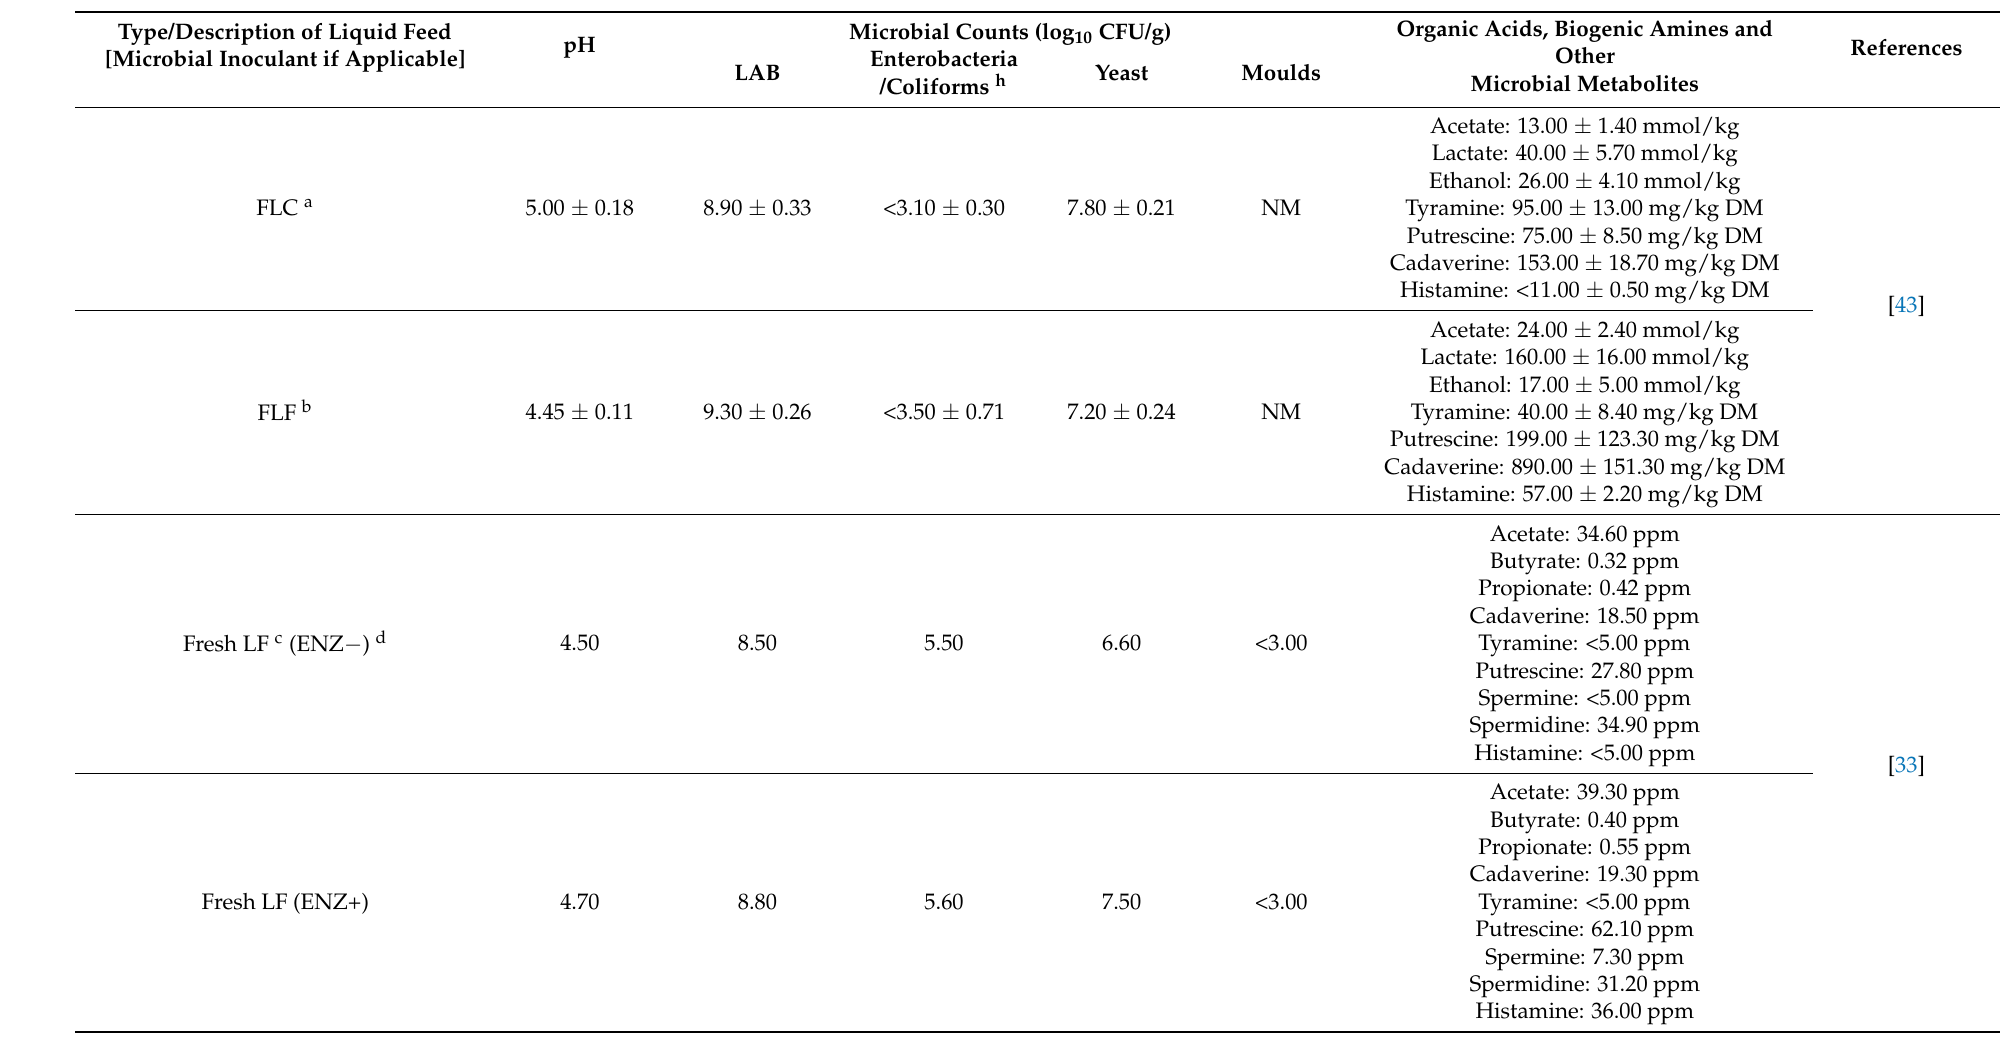
Table 4. Microbial and physicochemical properties of fresh, fermented, cereal fraction only fermented, soaked, acidified, and enzyme-supplemented liquid